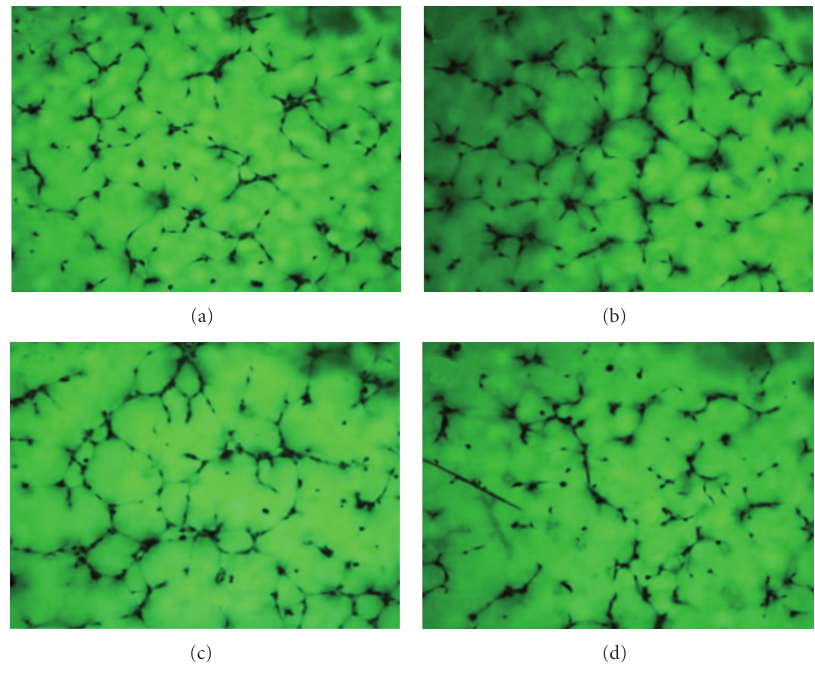
Figure 2: E ff ects of the standardized RVS extract on the tube formation in VEGF-stimulated HUVECs. (a) HUVECs seeding in Matrigel form capillary networks; Control. (b) The robust and complete tube network formation after VEGF alone. (c) VEGF plus RVS (50 μ g/mL). (d) VEGF plus RVS (100 μ g/mL) showing inhibitory e ff ect on tube network formation compared to only VEGF-treated